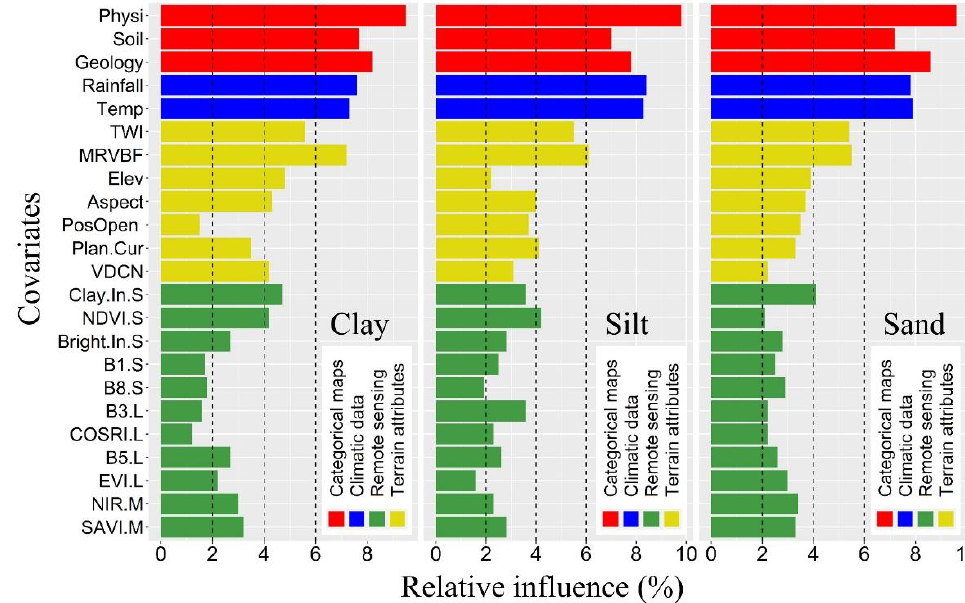
Figure 4. The relative influence of environmental covariates for predicting clay, silt, and sand contents using the MBO-ANN algorithm. (Refer to Table A1 for covariate codes).